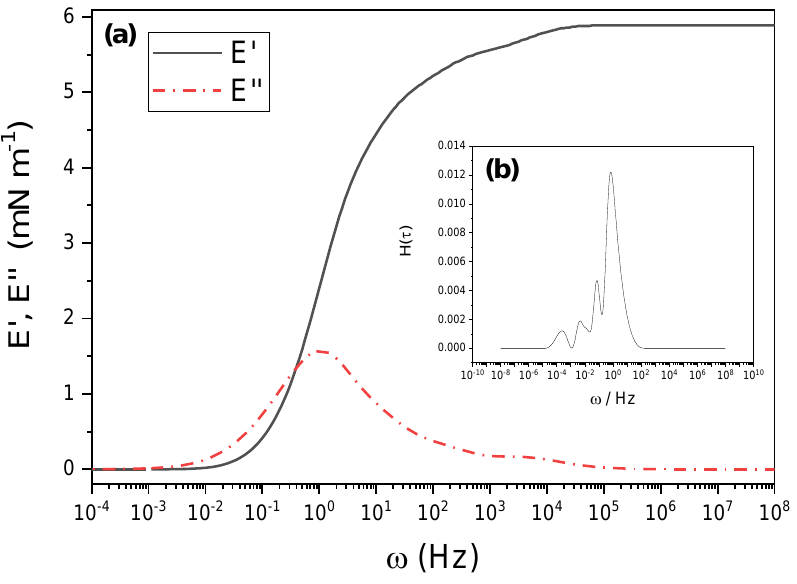
Figure 6. ( a ) Storage, E′, and loss, E″, moduli measured from step-compression experiments on a Langmuir balance and analyzed using Equation (4) after applying an inverse Laplace transform by means of the CONTIN algorithm. The results correspond to 1 mg mL −1 PAA + 0.1 mM G12 at pH 3.5. ( b ) H(τ) from CONTIN.